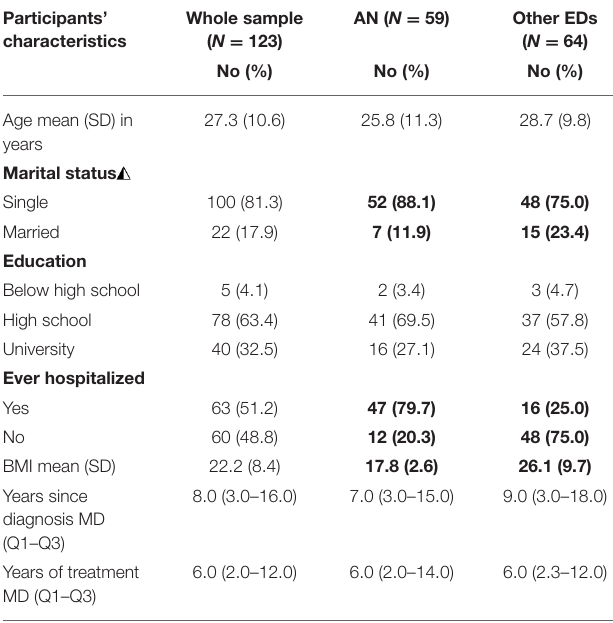
TABLE 1 | Sociodemographic and clinical characteristics of the participants in the samples. Participants’